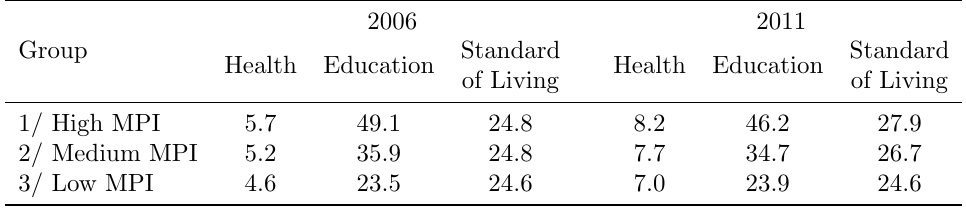
Table 6: Headcount ratio (%) for dimensional specific MPI values for each group